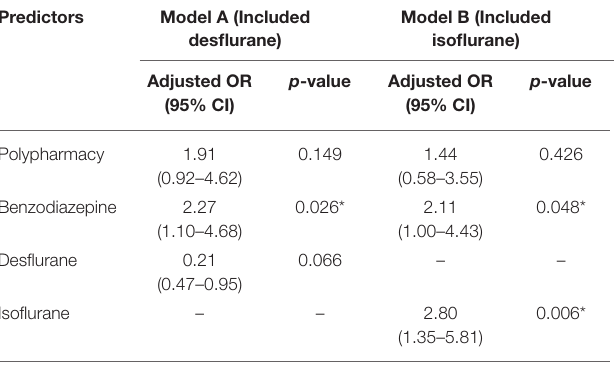
TABLE 6 | Multivariate analyses (models A and B) to identify independent predictors of postoperative cognitive dysfunction (POCD) in older adult patients after major